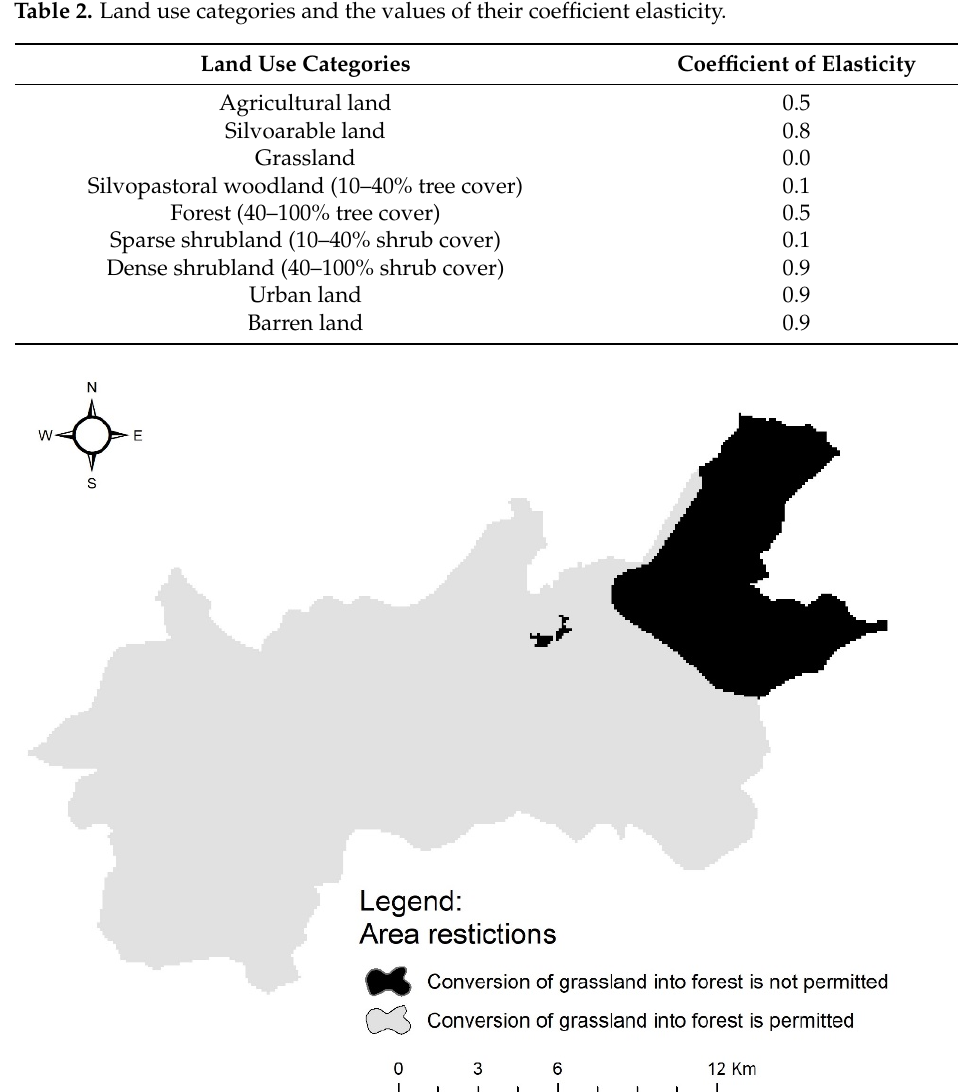
Figure 2. Eastern lowland areas of the landscape of Mouzaki, where the conversion of grassland into forest is not permissible, as reflected in the matrix of permissible transformations.